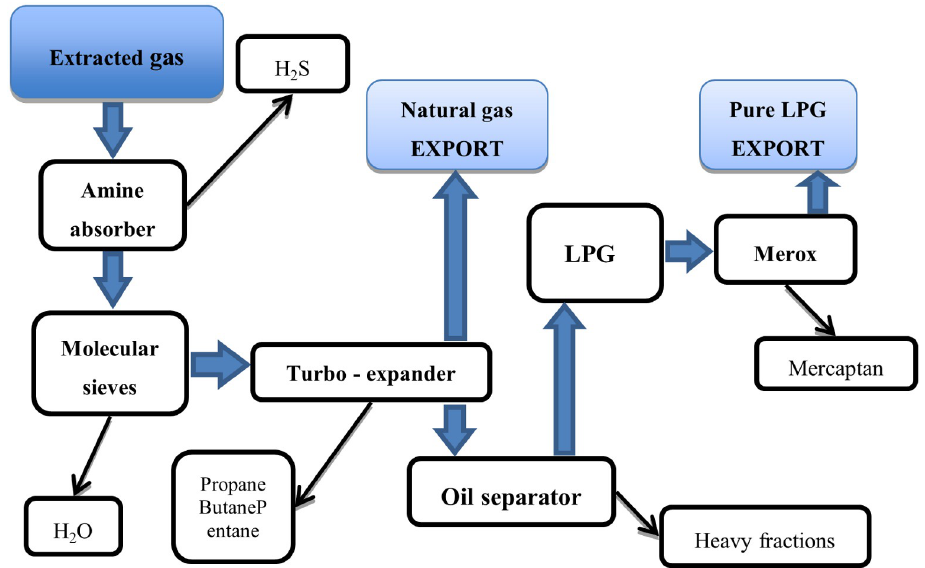
Fig 2. A simplified diagram of the gas processing